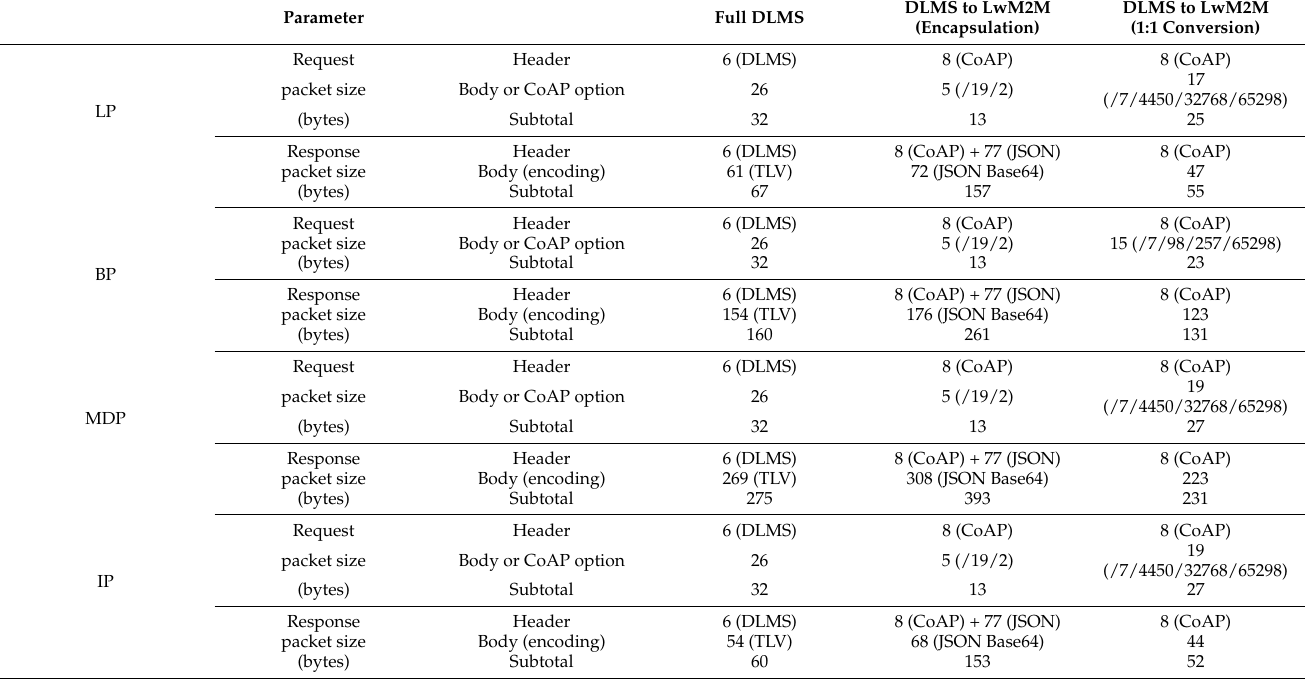
Table 7. Analysis of the packet size for three different remote metering